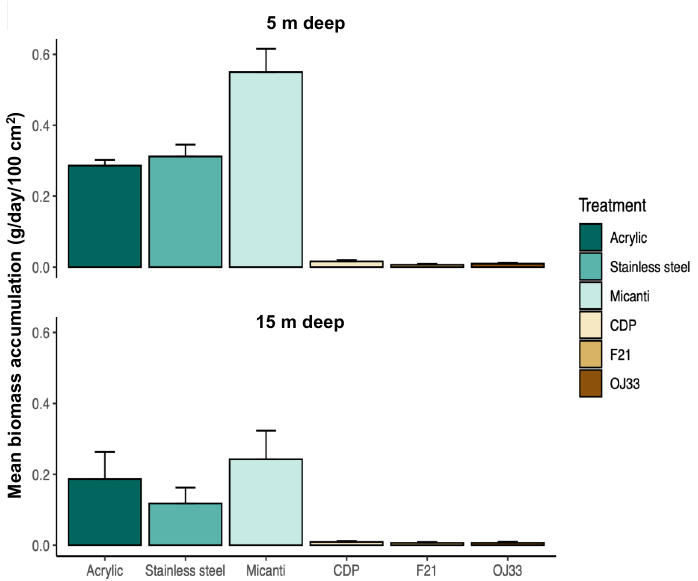
Figure 3. Mean biomass accumulation (g/day/100 cm 2 ± SE) in the different experimental materials and coatings over 12 months of exposure at the two depths of deployment, before urchin removal.